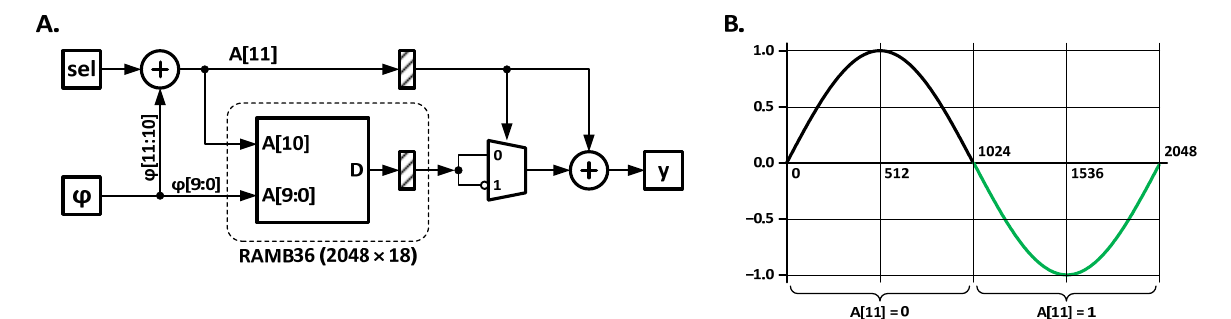
Figure 10. The block diagram of trigonometric functions sine and cosine fast computation module using RAMB36 lookup method ( A ) and operation concept ( B ).